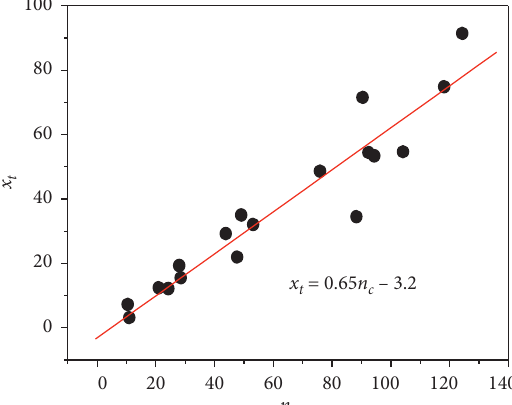
Figure 12: Relationship between x